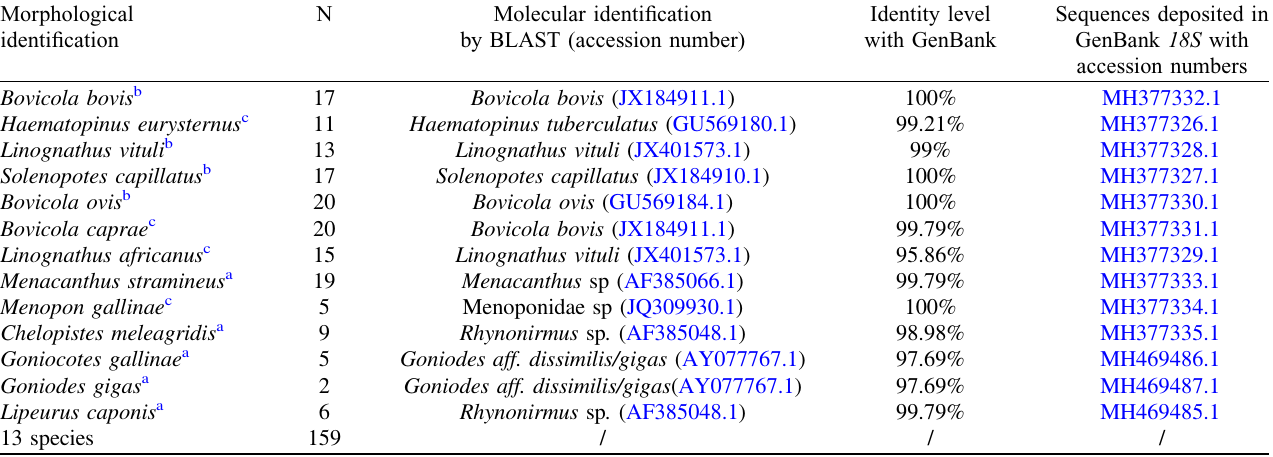
Table 3. Results of the molecular identi fi cation based on the partial 18S rRNA of lice: BLAST analysis and sequences deposited on the NCBI GenBank database.